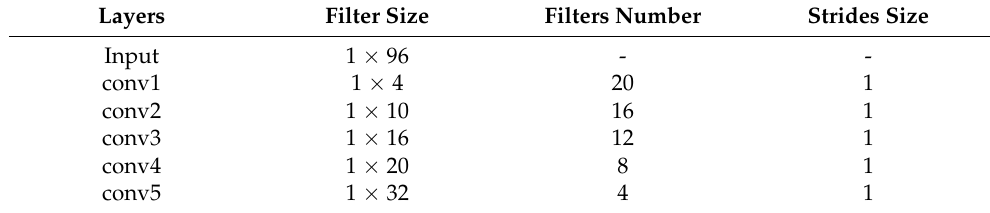
Table 6. CNN-2 configuration of convolution